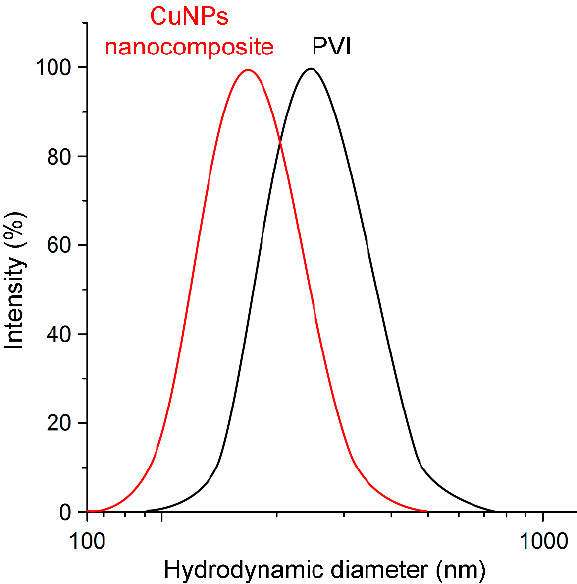
Figure 4. Histogram of the distribution over the hydrodynamic diameters of the scattering particles of NC(Cu-PVI) and the initial PVI.